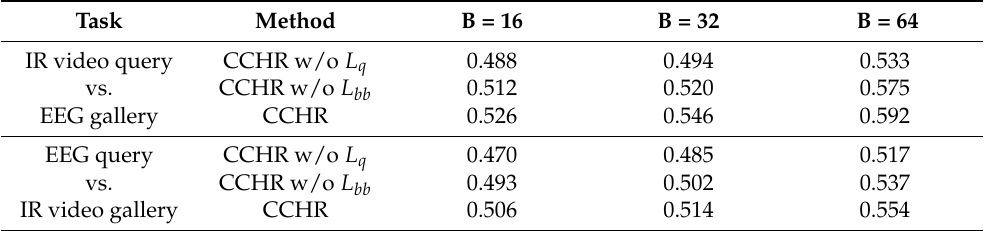
Table 4. Ablation studies on the hashing loss of our cross-modal contrastive hashing retrieval. “CCHR w/o L q ” indicates our CCHR without the quantization loss.